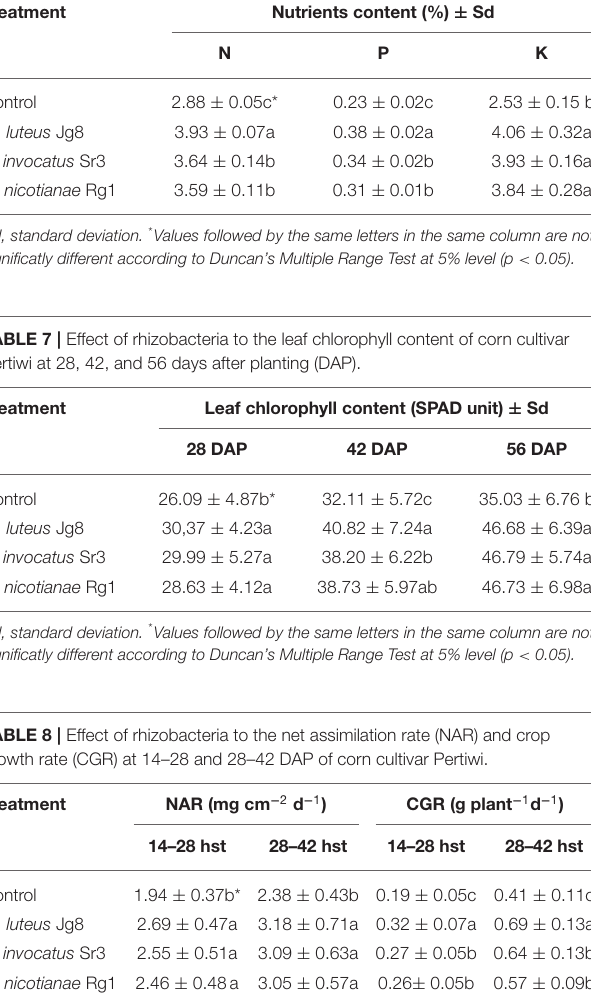
TABLE 6 | Effect of rhizobacteria to the content of N, P, and K in the leaf of corn cultivar Pertiwi at 28 days after planting (DAP). Treatment